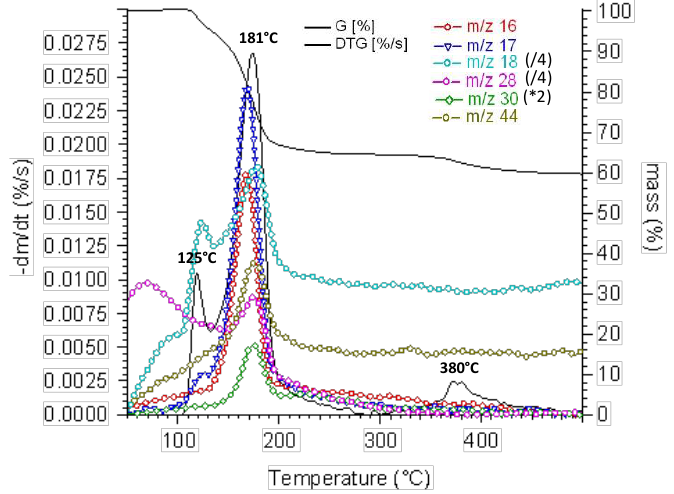
Figure 8. Thermal decomposition curves of compound 3-Mn in an argon atmosphere.